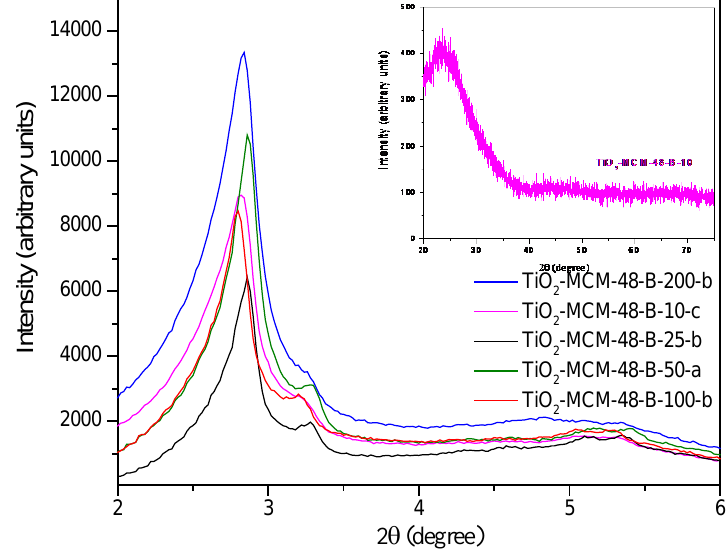
Figure 2. The short range powder XRD patterns of TiO 2 -MCM-48 materials prepared by method B. The inset shows the long range XRD of TiO 2 -MCM-48-B-10. Nitrogen adsorption experiments were carried out for all the TiO 2 -MCM-48 materials at 77